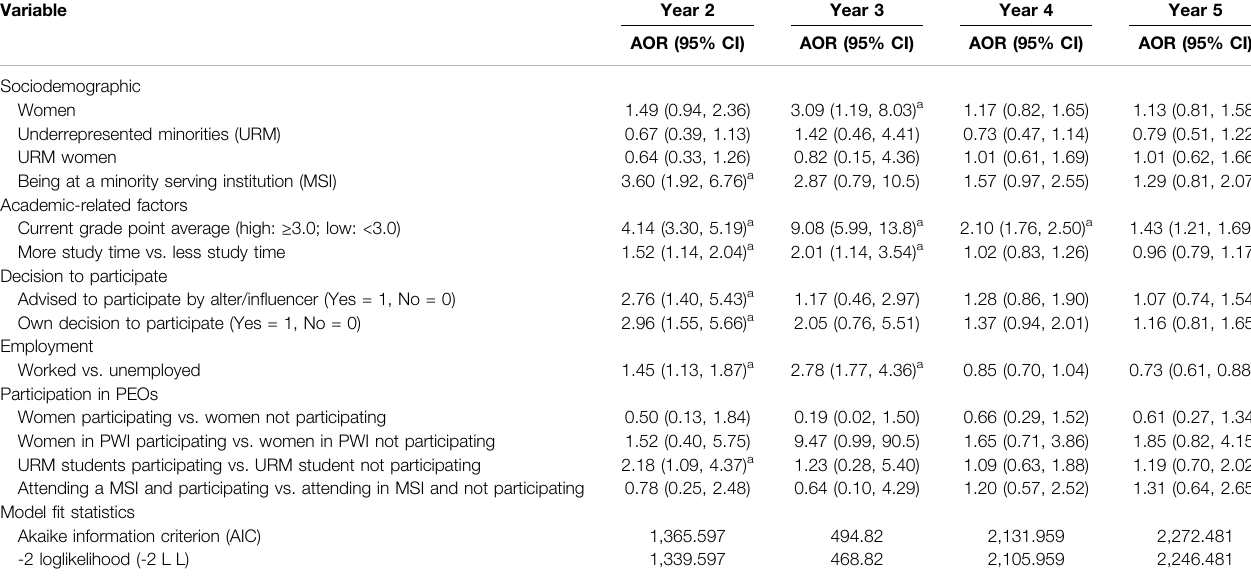
TABLE 5 | Prediction of Enrollment in Year 2, Year 3, Year 4, and Year 5.